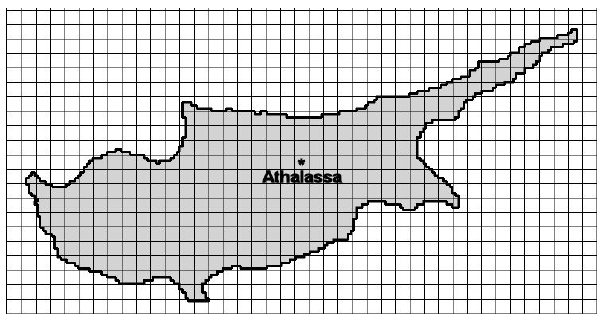
Fig. 1. The study area. The MODIS derived PW and the AVHRR derived 1T were spatially averaged in 5 × 5km. For this rea- son a grid of 5 × 5km cells was developed (Projection: Geo- graphic/WGS84). The location of the Athalassa synoptic station is